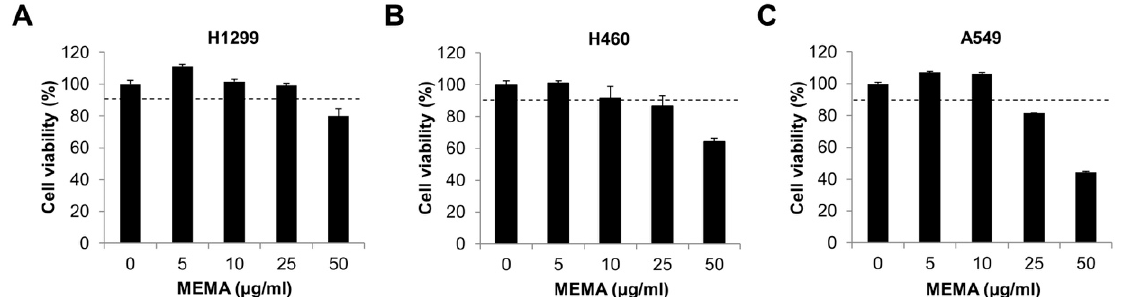
Figure 2. Effects of MEMA on cell viability in human non-small-cell lung cancer (NSCLC) cells. H1299 ( A ), H460 ( B ), and A549 ( C ) human NSCLC cells were treated with MEMA for 48 h. The cell viability was evaluated by MTT assay. Data are expressed as the mean ± SD of three independent experiments. The dotted line indicates the cell viability of 90%.